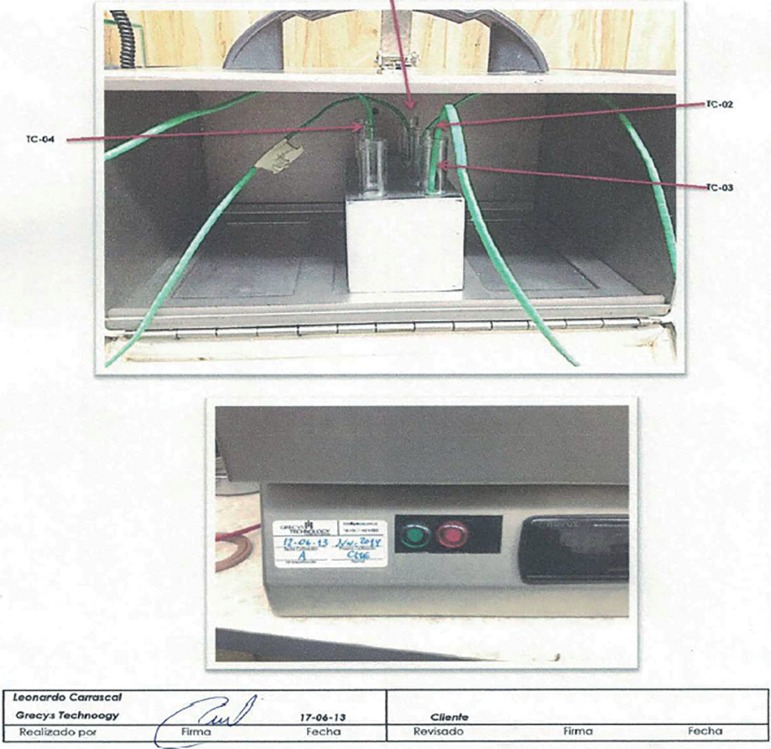
Temperature control in portable incubator